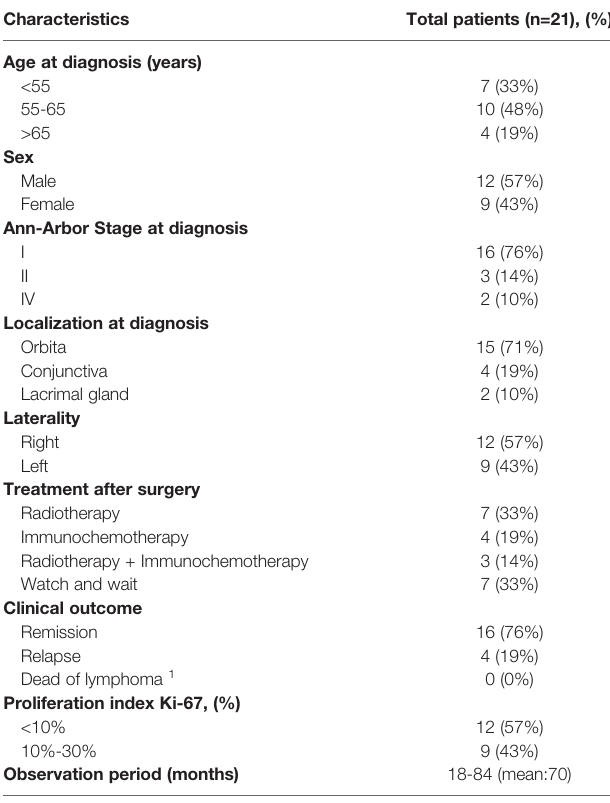
TABLE 1 | Clinical and staging course of patients with ocular adnexal extranodal marginal zone B-cell lymphoma.